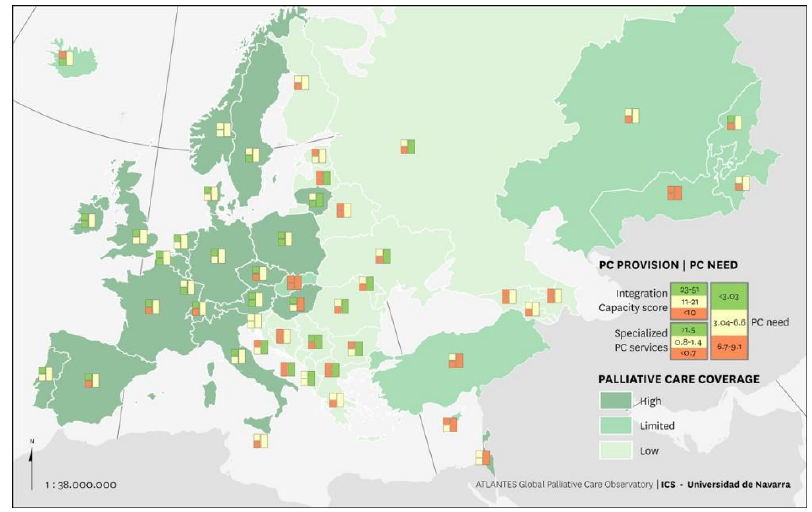
Figure 1. Palliative care country coverage level in Europe.